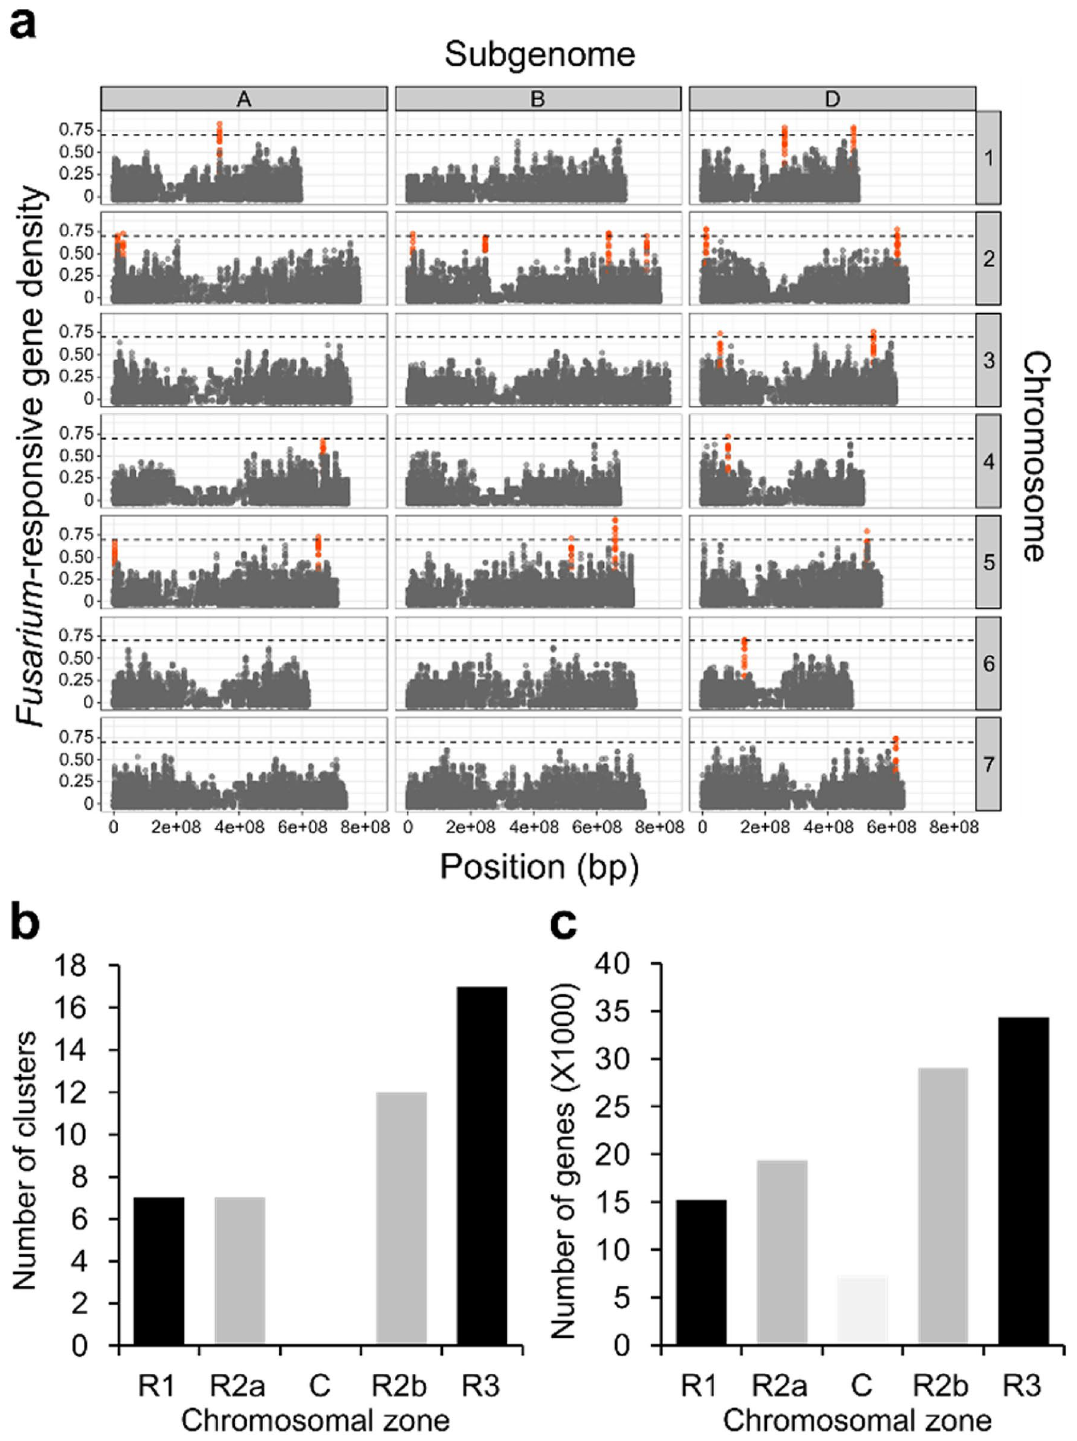
Figure 2. Chromosomal distribution of Fusarium -responsive gene clusters (FRGCs). ( a ) Fusarium -responsive gene density along each wheat chromosome. A sliding window of 10 genes was used to screen each chromosome and calculate the Fusarium -responsive gene density. A significance threshold (dashed line) was calculated by 10,000 random permutations of the data and enriched Fusarium -responsive gene loci (those that passed the threshold) were identified and are represented in red vermillion. ( b ) Number of FRGCs and ( c ) total number of high confidence genes are shown in bar diagrams with their distribution in different chromosomal zone such as distal telomeric (short arm (R1) and long arm (R3)), interstitial regions (short arm (R2a) and long arm (R2b)) and centromere regions (C), according to 17